Question: Write a descriptive caption for this figure.
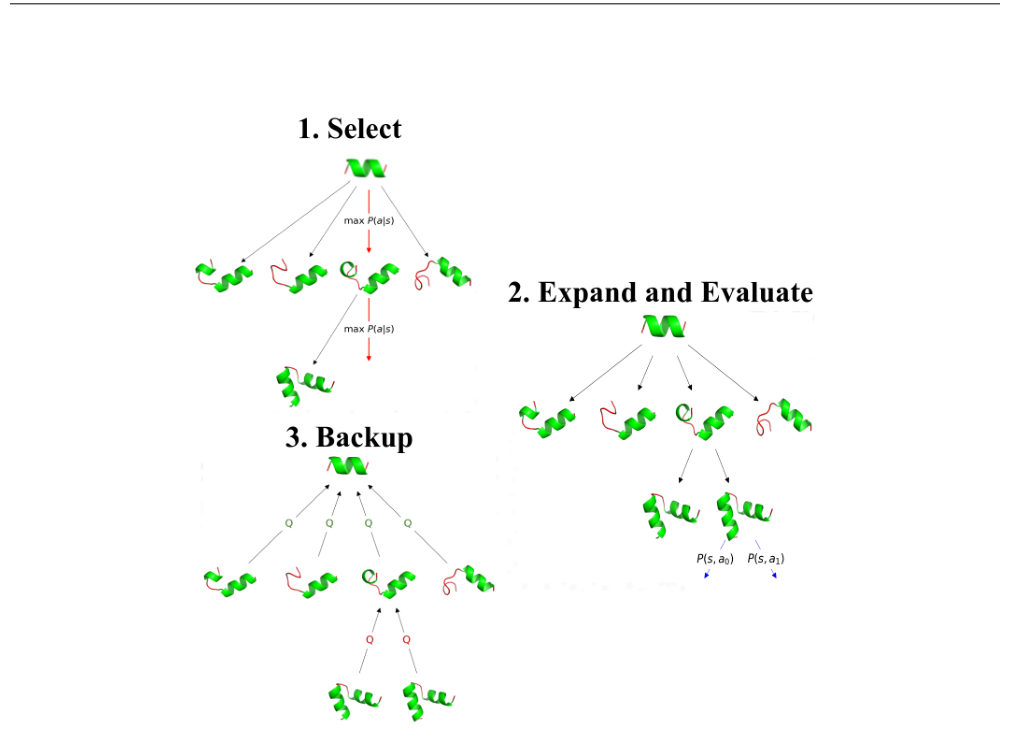
Answer: Diagram of the AlphaZero algorithm action selection process. Starting from the root node, the tree of states and actions is expanded by the repetition of the select, expand and evalu- ate, and backup phases. First, a new child node is selected by maximizing P(a|s) = Q(s, a) +